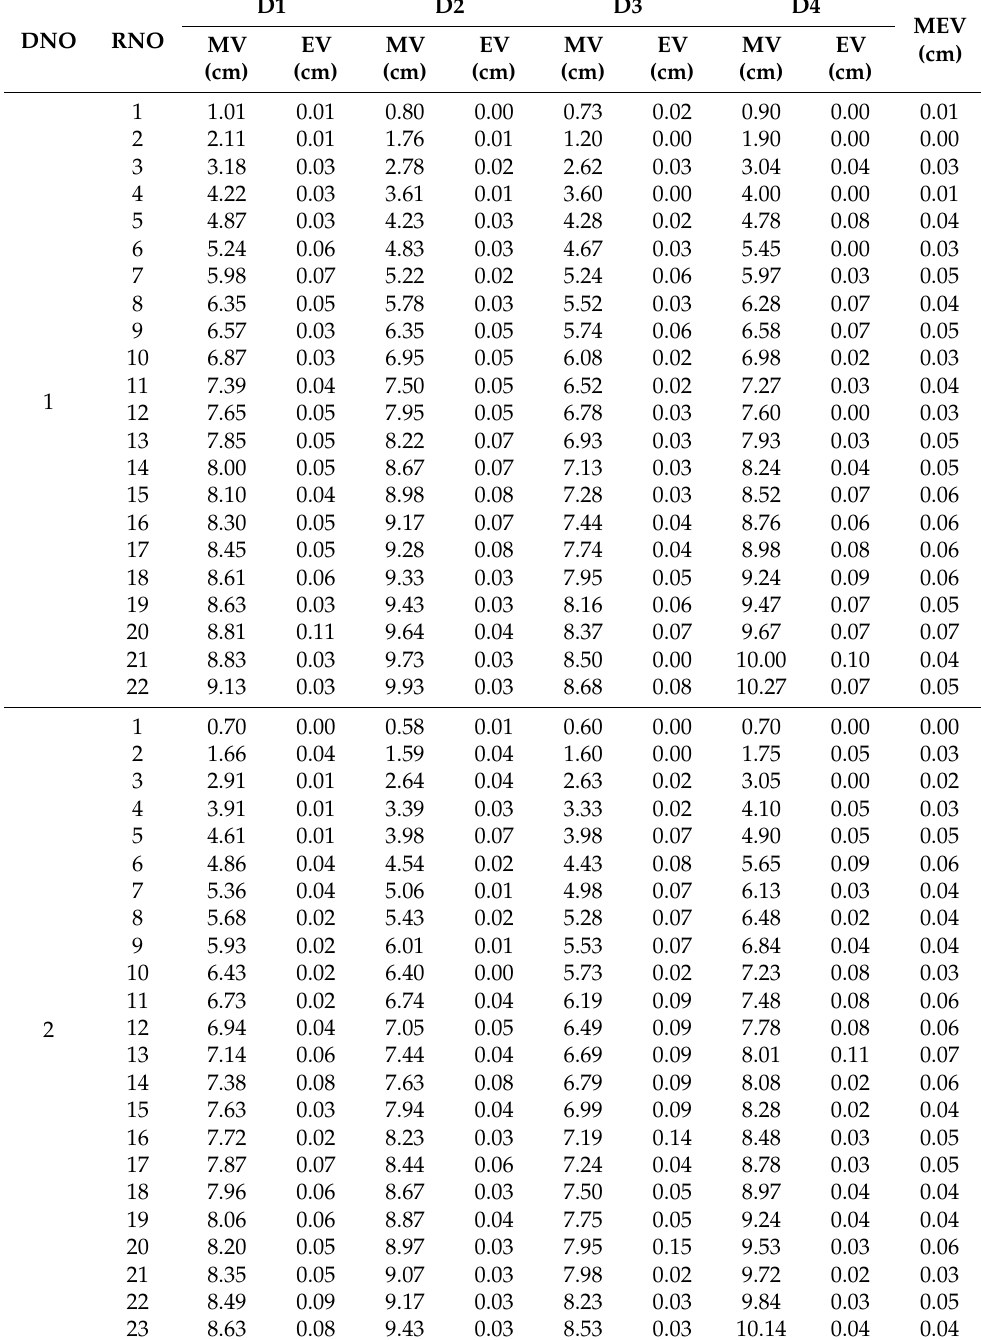
Table 4. The measured data of tree ring radius of Chinese fir disk. DNO is the number of the sample of the stem analysis disk. RNO is the number of the growth ring (the number starts at the heart of the pith). D1, D2, D3, and D4 represent four measurement directions. PD is the pixel distance from this ring to the heart of the pith. MV is the measured value of the ring radius calculated by the system according to the regression equation of tree ring radius based on the polynomial type correction model. EV is the error value of the ring radius. MEV is the mean of the error